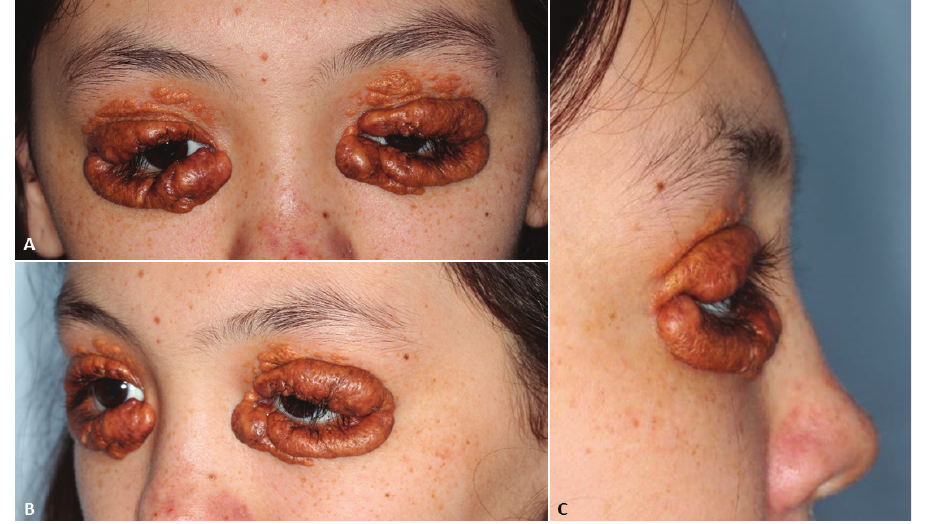
Figure 1. Demonstration of extensive upper and lower lid lesions (A, B, C) with satellite lesions extending towards upper